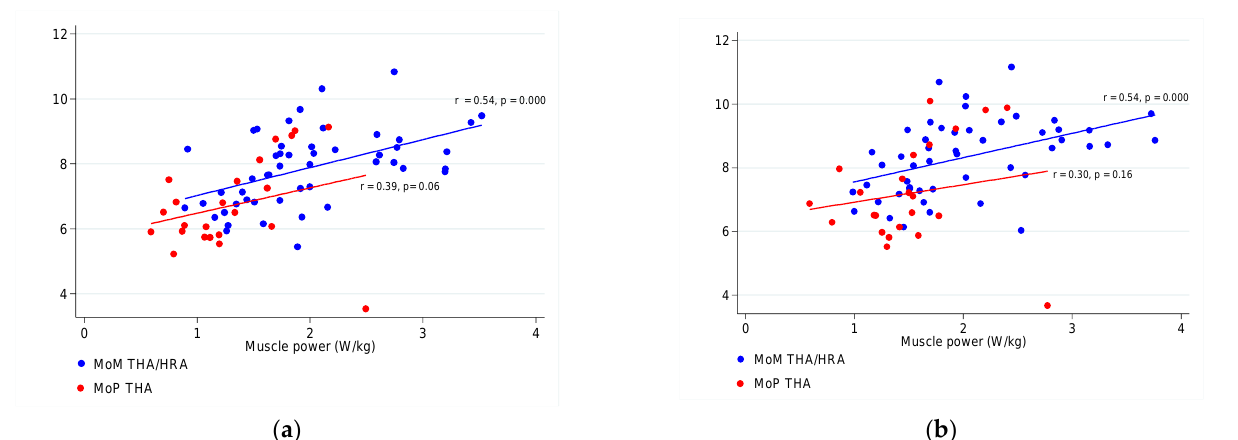
Figure 3. ( a ) Correlations between the mean hip and thigh muscle mass (g/cm 2 ) and the mean muscle power (W/kg) in the implant-side leg of MoM THA/HRA and MoP THA patients. ( b ) Correlations between the mean hip and thigh muscle mass (g/cm 2 ) and the mean muscle power (W/kg) in the non-implant side leg of MoM THA/HRA and MoP THA patients.